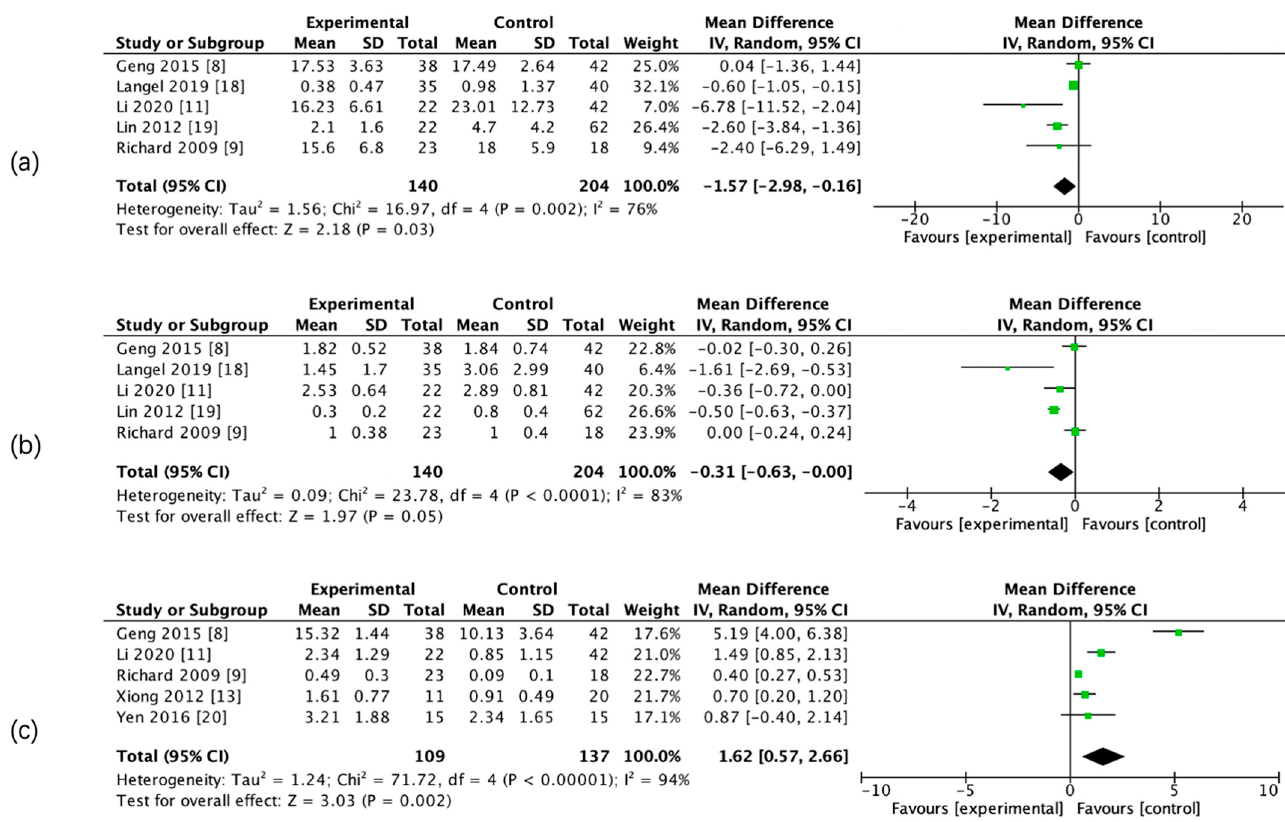
Figure 3. Forest maps of absolute computed tomography perfusion (CTP) parameters for hemorrhagic transformation (HT) and non ‐ HT groups. CBF ( a ), CBV ( b ), and PS ( c ).